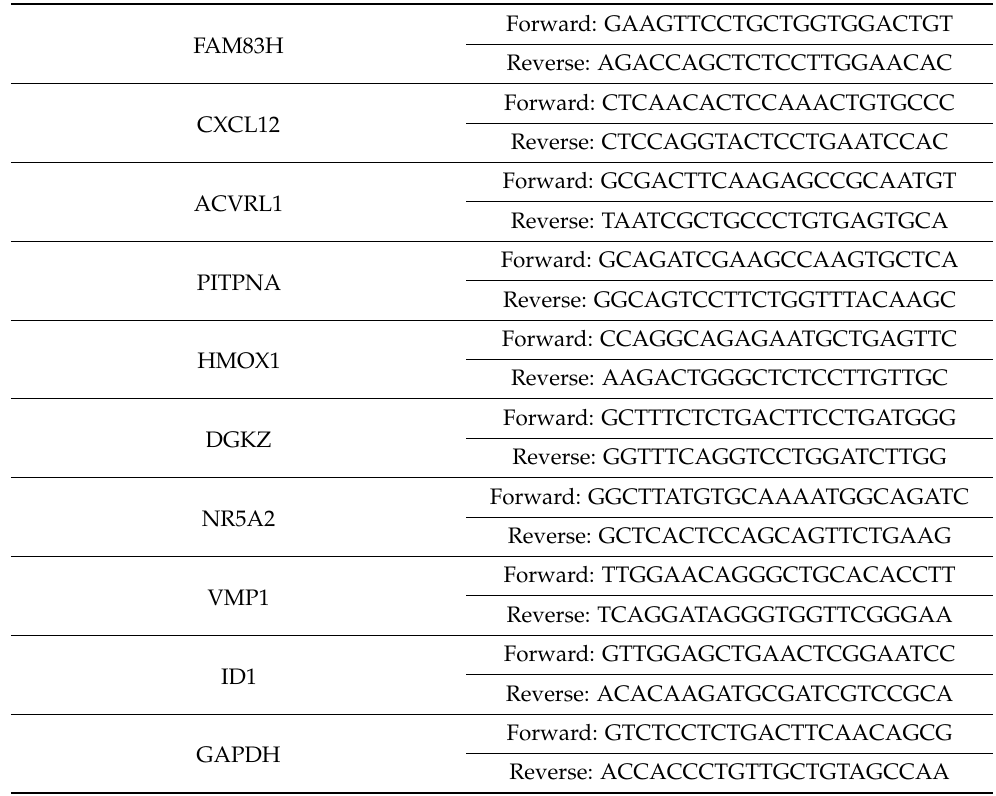
Table 1. Sequence of primers used for qRT-PCR in this